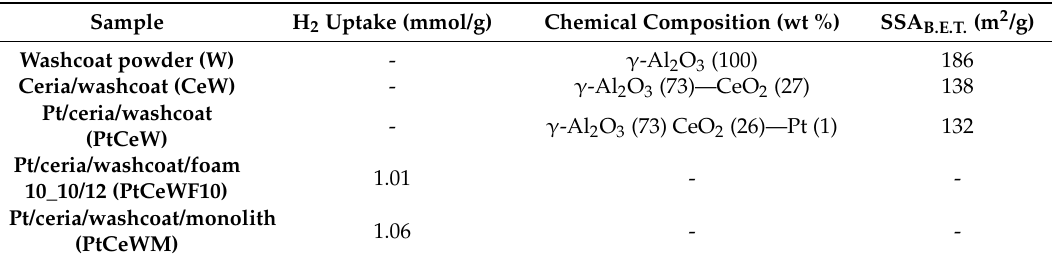
Table 1. The H 2 uptake in the temperature programmed reduction (TPR) experiments, chemical composition, and specific surface area.